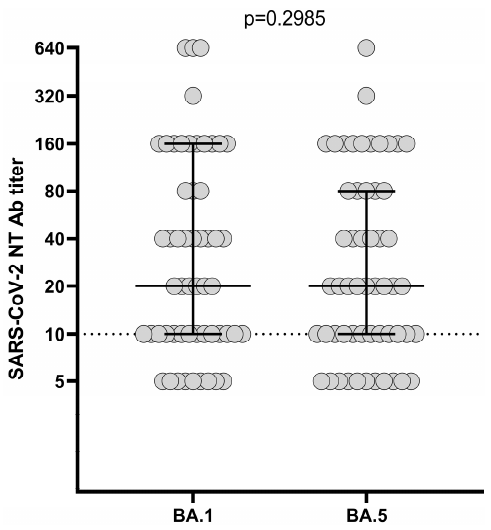
Figure 2. SARS-CoV-2 NT Ab titer measured 12 months after the third dose against Omicron 1 (BA.1) and Omicron 5 (BA.5) variants; NT Ab, neutralizing